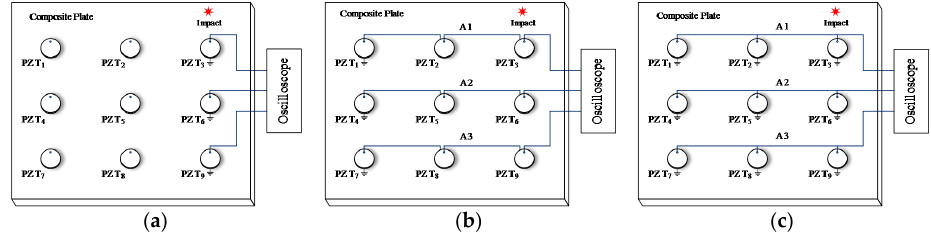
Figure 6. Different sensor connection types: ( a ) Independent connection; ( b ) Series connection; ( c ) Parallel connection.